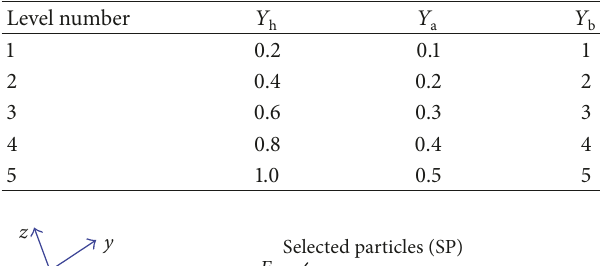
Table 4: Dimensionless parameters to describe the finlike asperity and associated levels.